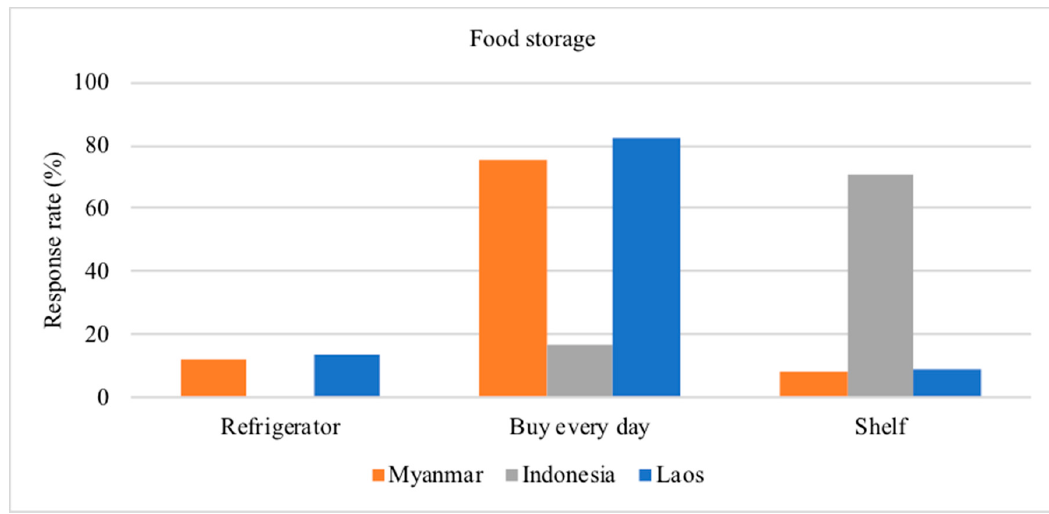
Figure 3. Ways of food storage in the three case study villages.